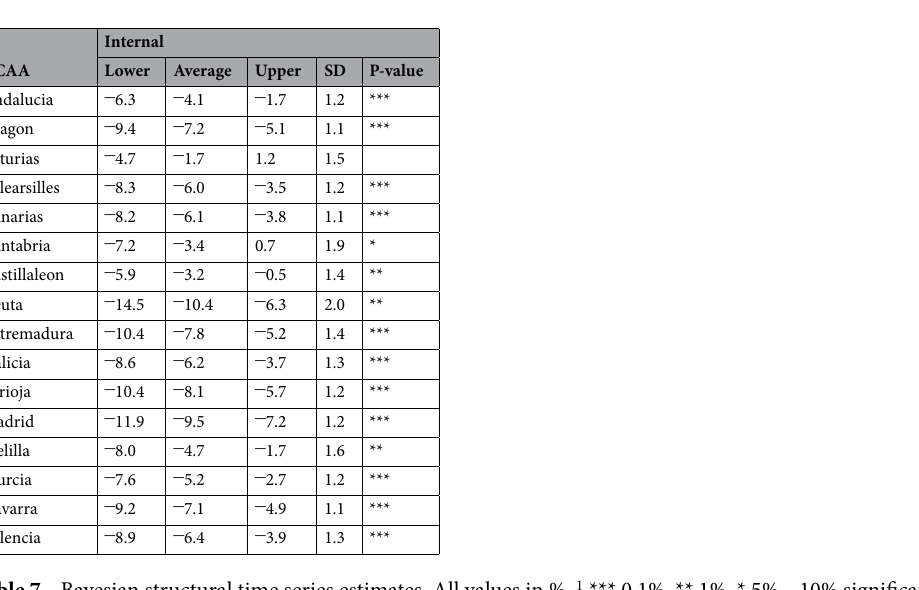
Table 7. Bayesian structural time series estimates. All values in %. 1 *** 0.1%, ** 1%, * 5%, . 10% significance